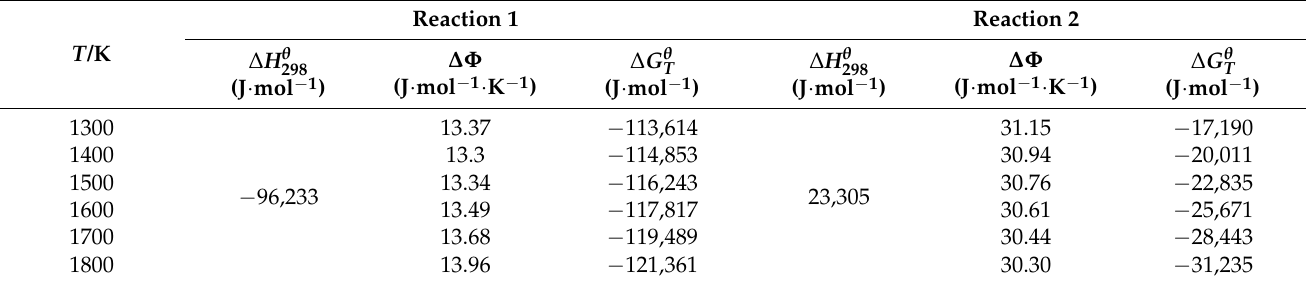
of Reaction 1 and Reaction 2. T